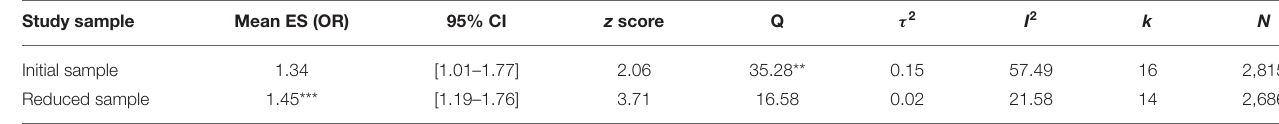
TABLE 3 | Summary statistics regarding parental psychopathology and CRIT. Study